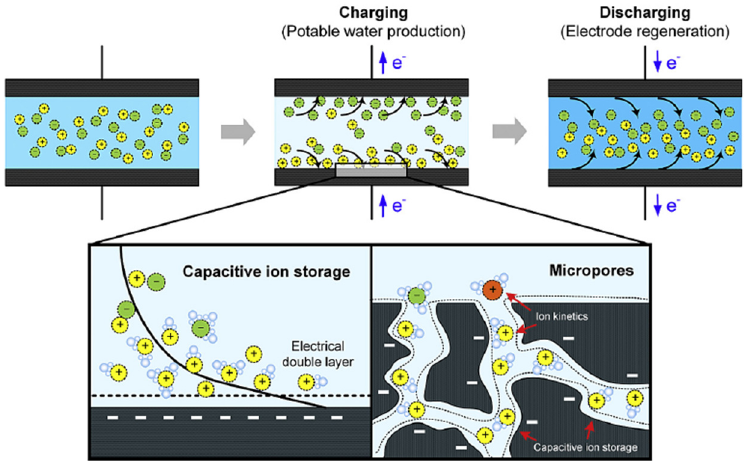
Figure 13. Diagram of capacitive deionization (CDI) operation and non-Faradic CDI processes [114].